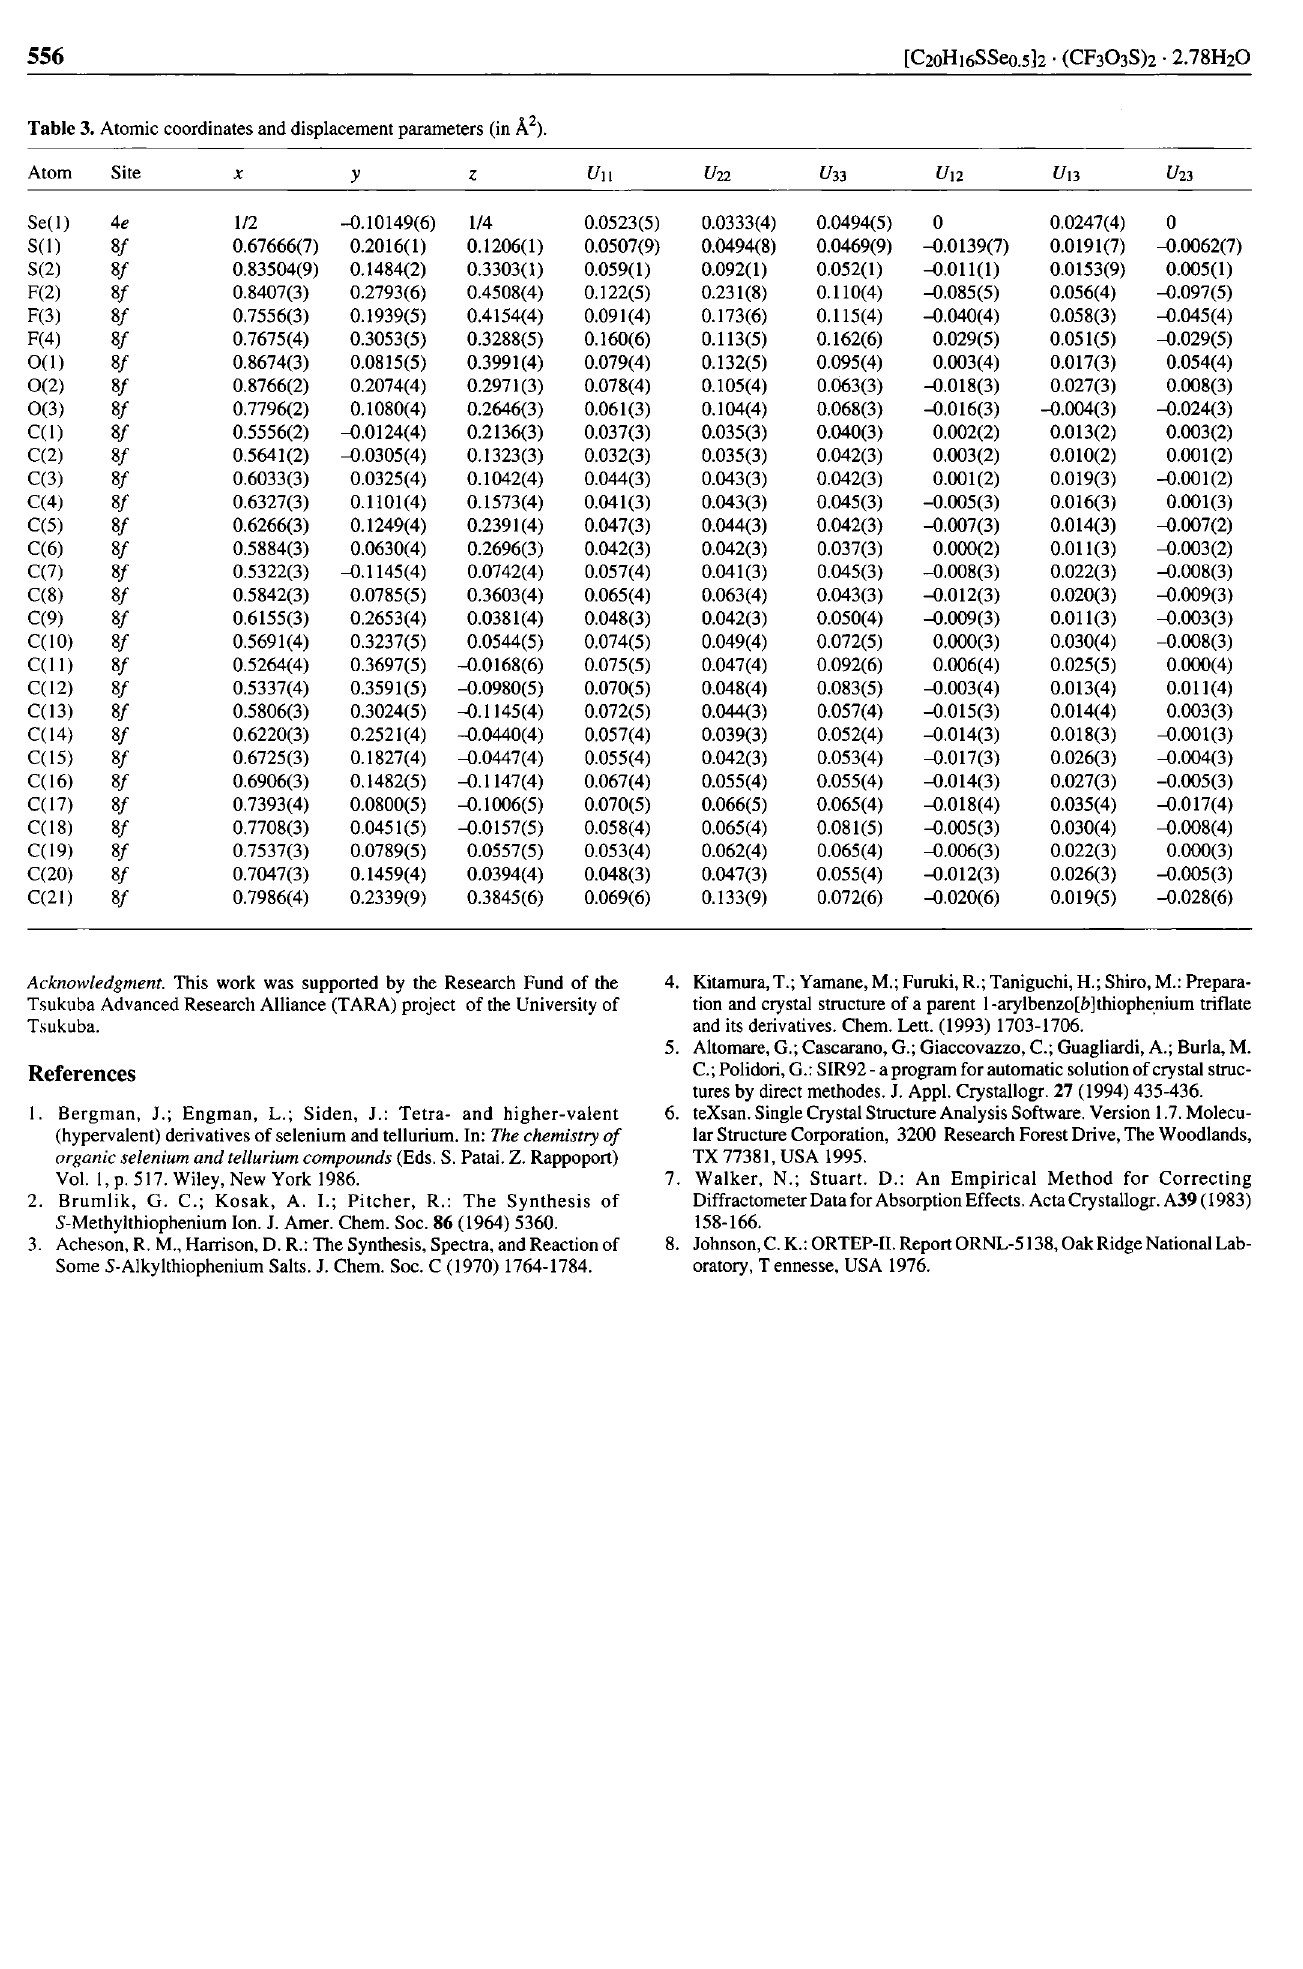
Table 3. Atomic coordinates and displacement parameters (in Â 2